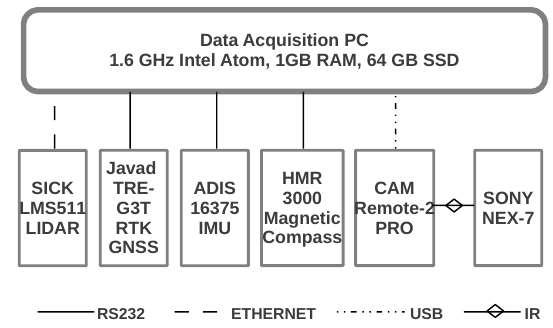
Figure 3: Schematics of the ALS and photogrammetric hardware